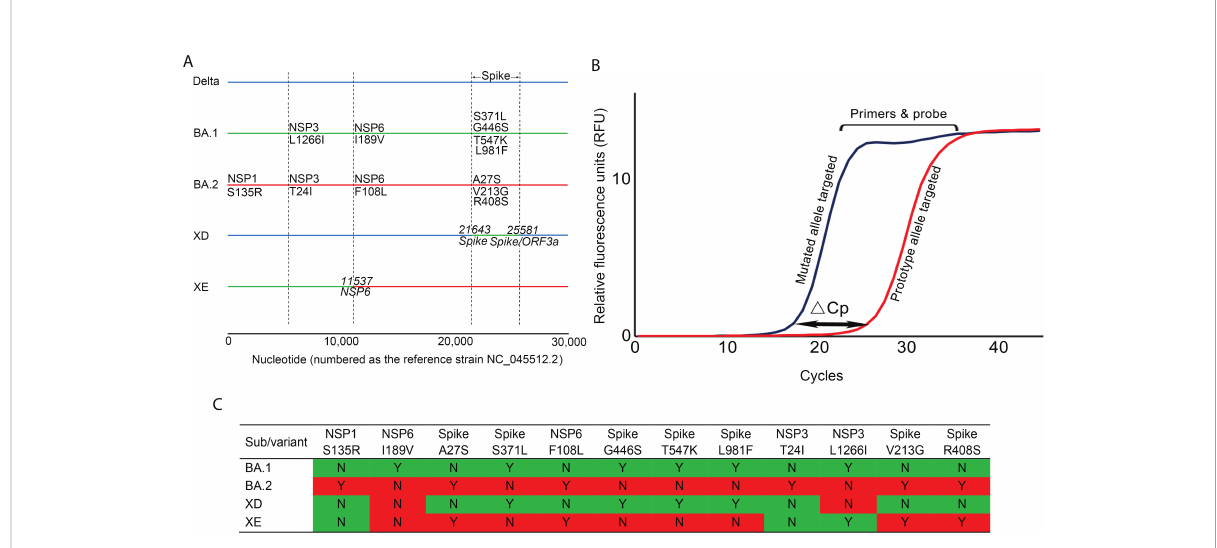
FIGURE 1 The principle and covered viral mutations of the developed multiplex allele-speci fi c qRT-PCR assays. (A) The viral genomic locations of the 12 targeted mutations in the developed multiplex allele-speci fi c qRT-PCR assays are shown, including 6 unique mutations in Omicron BA.1 subvariants (NSP3: L1266I, NSP6 I189V, Spike: S371L, Spike G446S, Spike T547K, Spike: L981F), 6 unique mutations in Omicron BA.2 subvariants (NSP1: S135R, NSP6: F108L, Spike A27S, Spike V213G, Spike R408s). The horizontal solid color lines represent the genome of the variant and subvariants of SARS-CoV-2. The vertical dashed lines indicate the boundary of viral genes. (B) The principle of the developed assays. The allele- speci fi c qRT-PCR assays consist of two parallel reactions targeting the prototype allele and the mutated allele of each mutation, respectively. The inaccurate matched primers & probe to viral RNA generates a higher Cp value, while the accurate matched primers & probe to viral RNA generates a lower Cp value. The variation of Cp values ( D Cp) between the prototype allele targeting and the mutate allele targeting reactions was employed to determine if a mutation occurred. (C) A total of 12 mutations were enrolled in the developed assays, with 4 unique mutation patterns to identify the Omicron subvariants BA.1 and BA.2, and the recombinant variants XD and XE of SARS-CoV-2. The mutation pattern for the Omicron subvariants BA.1 and BA.2 were colored in green and red, respectively, those for the recombinant variants XD and XE were colored